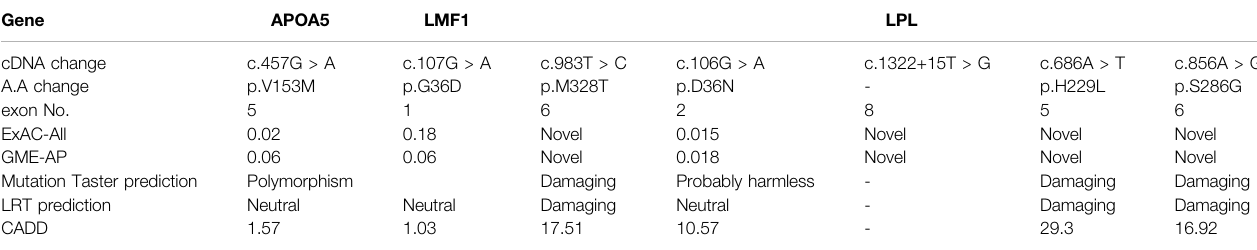
TABLE 1 | List of pathogenic variants in the families.